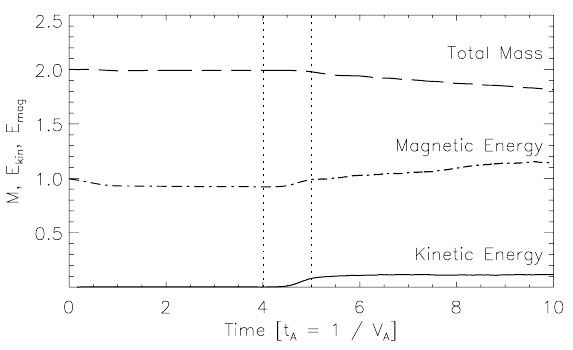
Fig. 4. Evolution of the reconnection rate V rec (black) for the same model as in Fig. 3. Blue line shows the evolution of reconnection in a model with the same parameters in which the turbulence were driven using the old method. In this plot, we present the measured rates of the Sweet-Parker reconnection V rec , SP and during the pres- ence of turbulence, V rec , LV . Symbol δV rec , LV is the time variance. 1V rec , LV is the estimated uncertainty of the